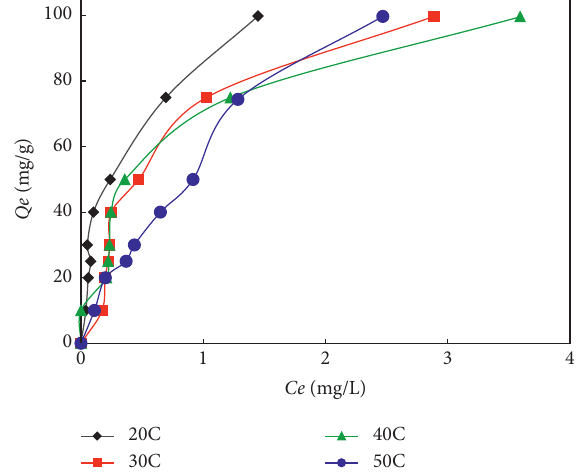
Figure 13: Effect of temperature on the adsorption capacity of Pb (II). Table 5: Thermodynamic parameters of adsorption of Pb (II). Metal